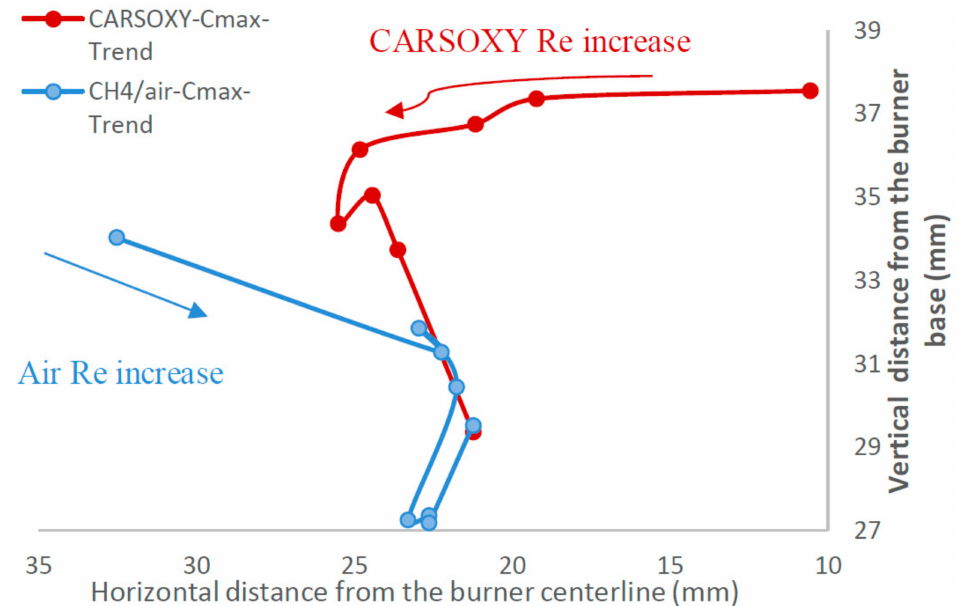
. V CH4 of 1 L/min Reynolds